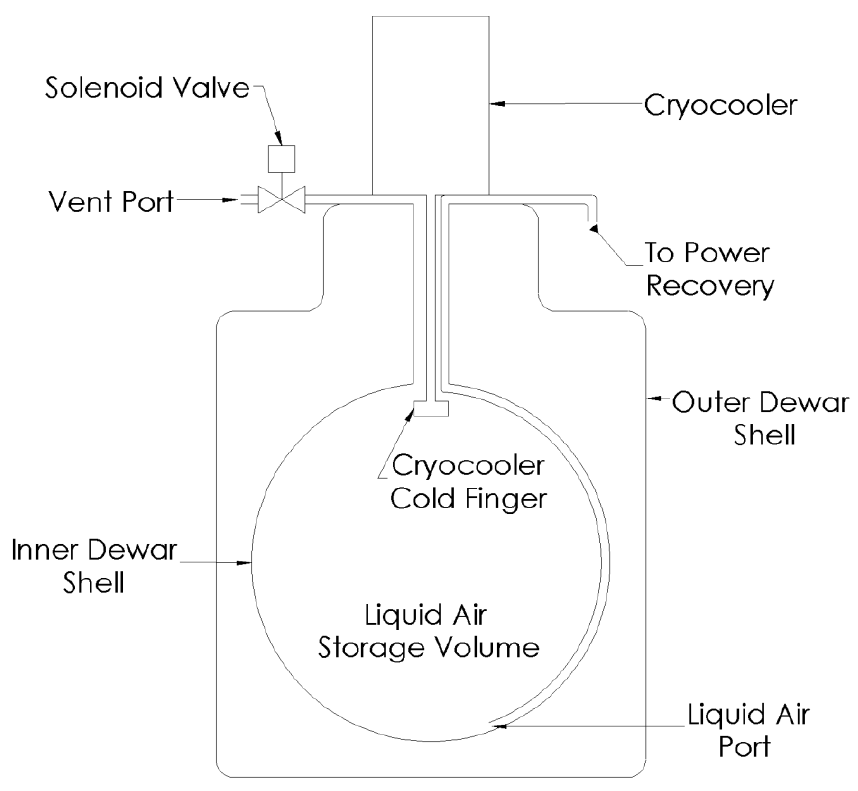
Figure 5. Proposed LA storage Dewar. The storage Dewar is normally unpressurized, but when power recovery is required by a connected microgrid, a solenoid valve on the vent port closes, allowing for a natural pressure increase to occur, forcing stored LA to be transported to a power recovery cycle.